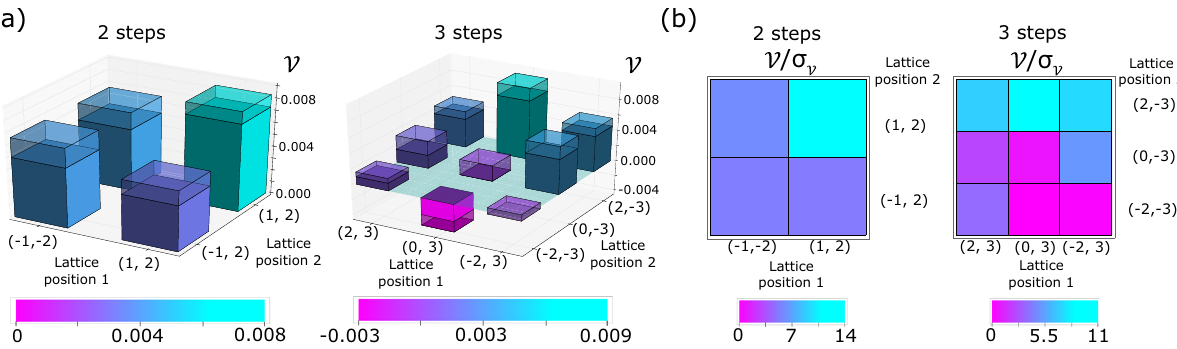
Fig. 6 Violation for the second and third step. a Plots of Vð r 1 ; r 2 Þ with their error σ V ð r 1 ; r 2 Þ for the second and third step, for the lattice sites that satisfy the conditions explained in Supplementary Note 7. b Plots of Vð r 1 ; r 2 Þ = σ V ð r 1 ; r 2 Þ , for those lattice sites where such quantity is positive, thus violating Eq. (5) for the second and the third